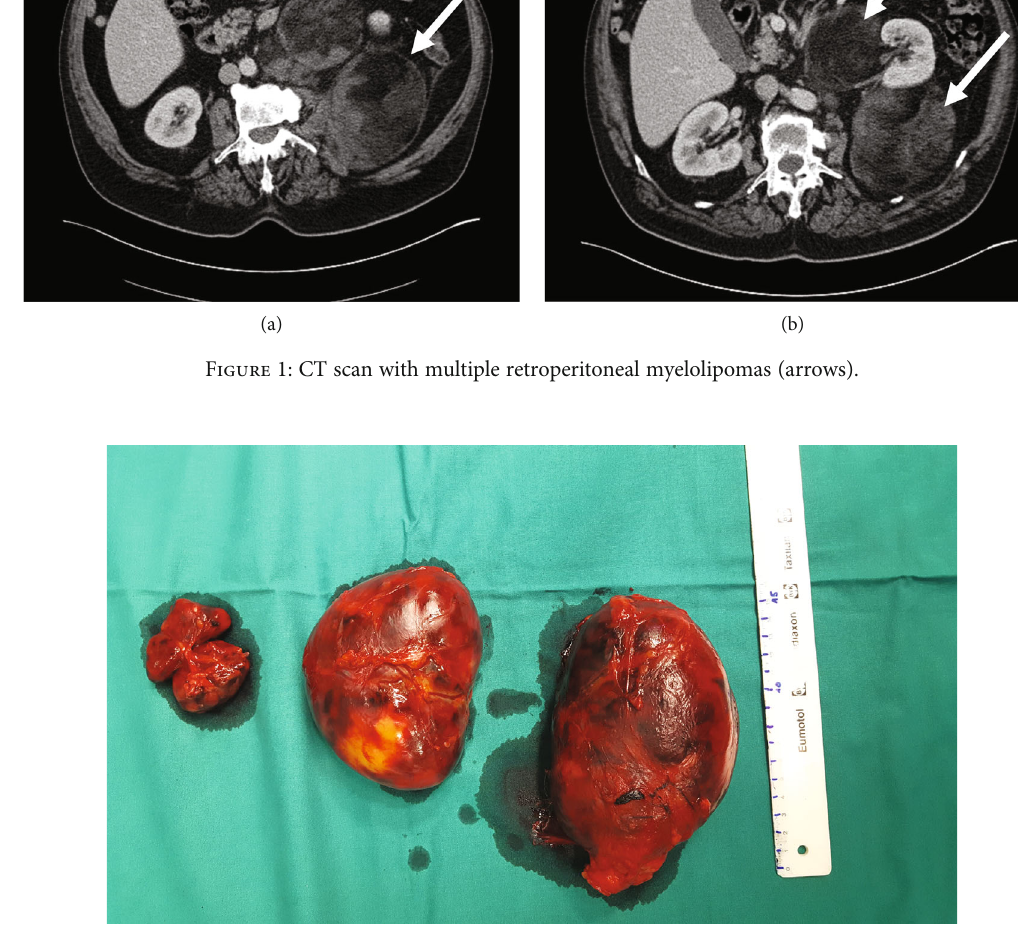
Figure 2: Gross appearance of surgically removed myelolipomas.